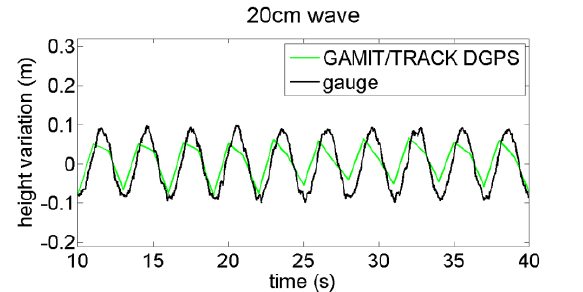
Figure 6(a). 20cm wave height time